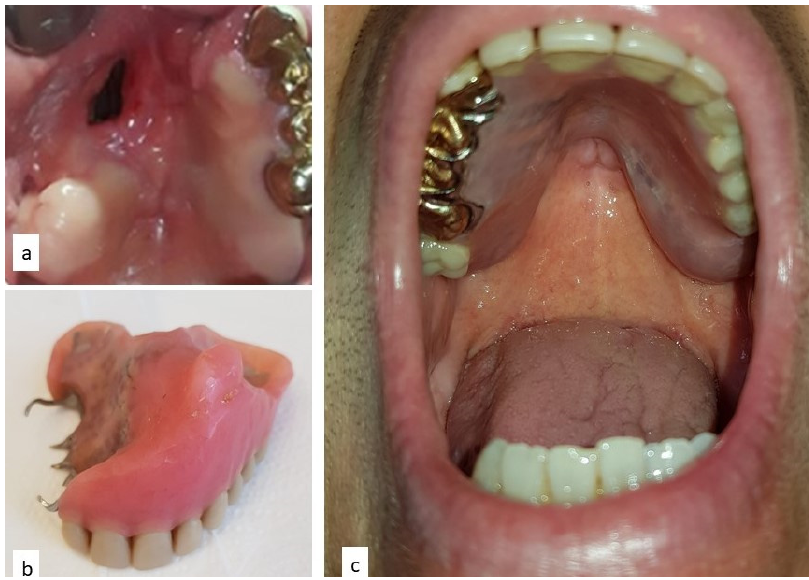
Figure 8. Post-operative defect of the palate with residual perforation: ( a ) receiving an obturator prosthesis ( b ) to improve chewing and protect airways ( c ).